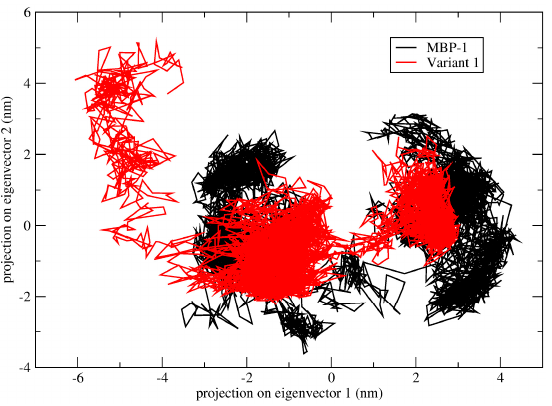
Figure 4. Motion projection in phase space along the first two principal eigenvectors of MBP-1 (black) and variant 1 (red). The trace of covariance matrix of MBP-1 and variant 1 was 11.287 and 9.989 nm 2 , respectively.